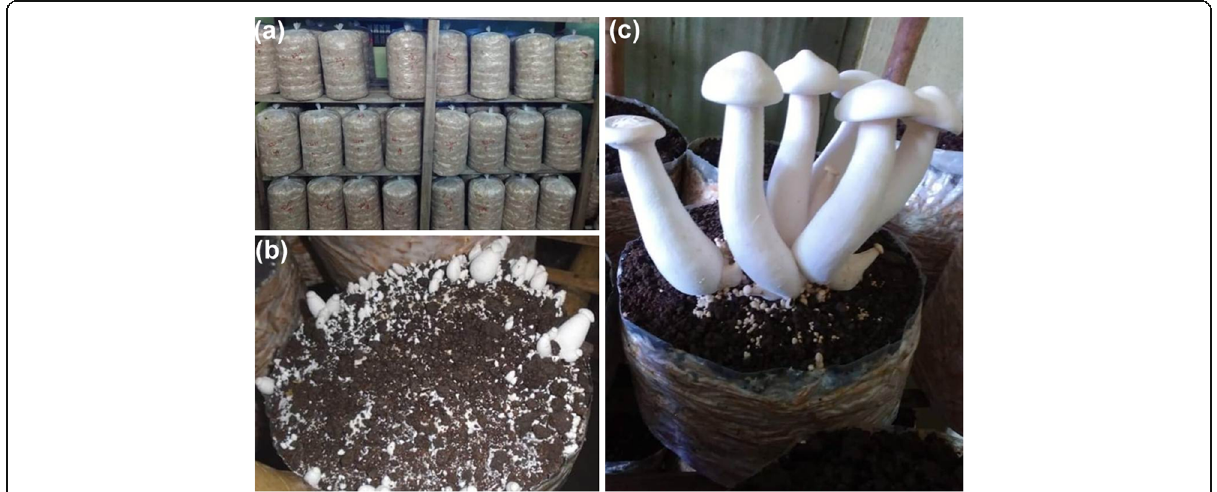
Fig. 3 The various stages of milky mushroom ( Calocybe indica ) cultivation at a spawn running stage, b pin head emerging stage, and c